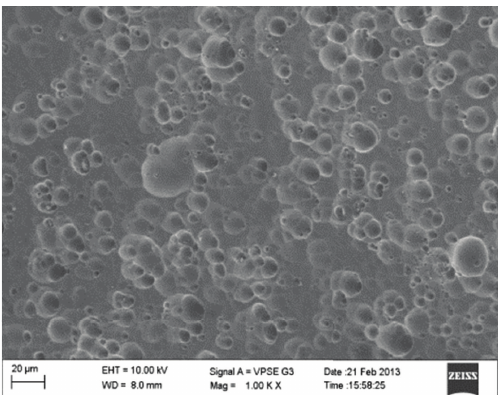
Figure 11: SEM image of aluminum after immersion in 0.5M H 3 PO 4